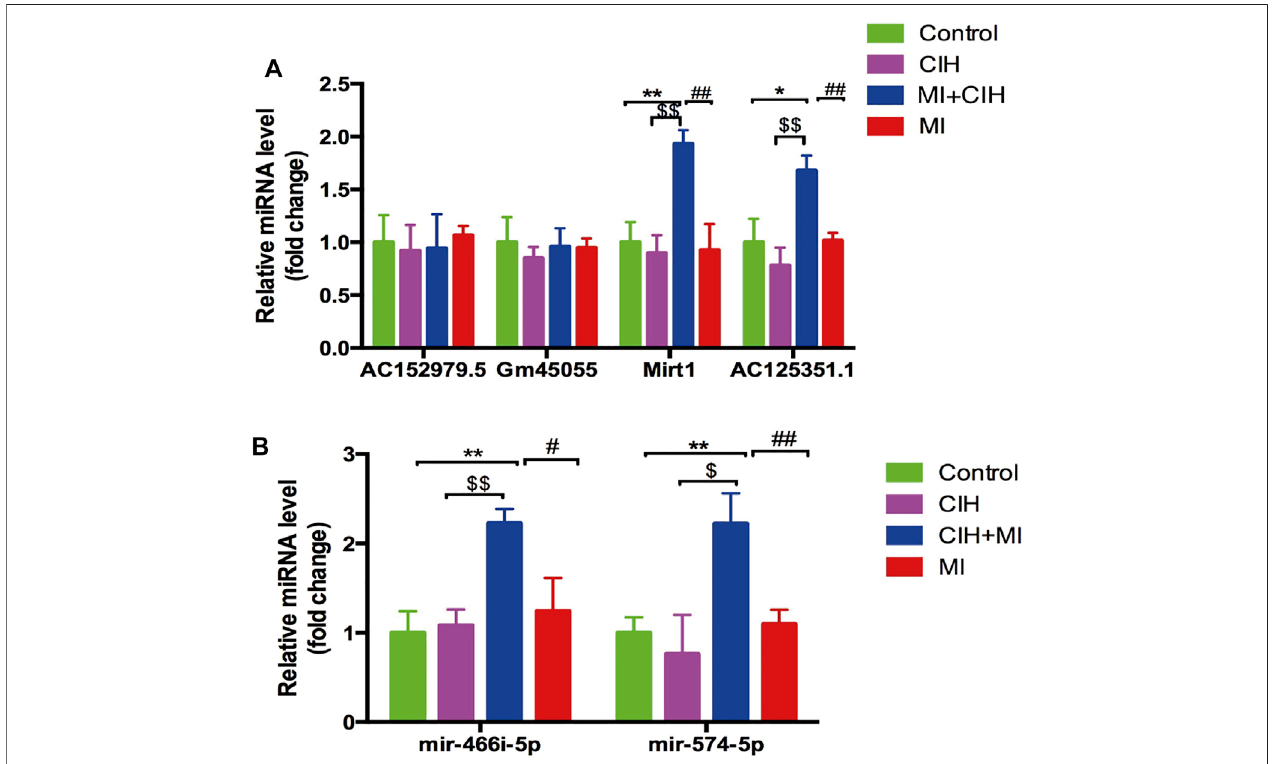
FIGURE 7| Quantitativereal-time PCR (qRT-PCR) validation offour selected lncRNAs and twomicroRNAs in RNA-sequencing results. (A) The expression level of lncRNAsGm45055,Mirt1,AC152979.5andAC125351.1. (B) TheexpressionlevelofmicroRNAsmiR-466i-5pandmiR-574-5p.SHAMvs.MI+CIH:* p < .05,** p < .01;